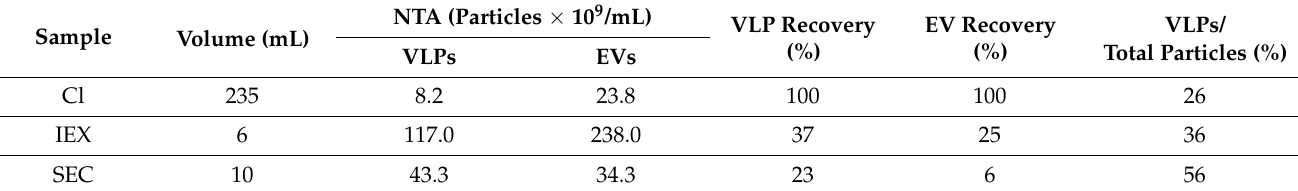
Table 2. Nanoparticle mass balance of VLPs and EVs based on NTA quantification. Cl: clarified material; IEX: E2 peak from EIX chromatography; SEC: SEC2 peak from